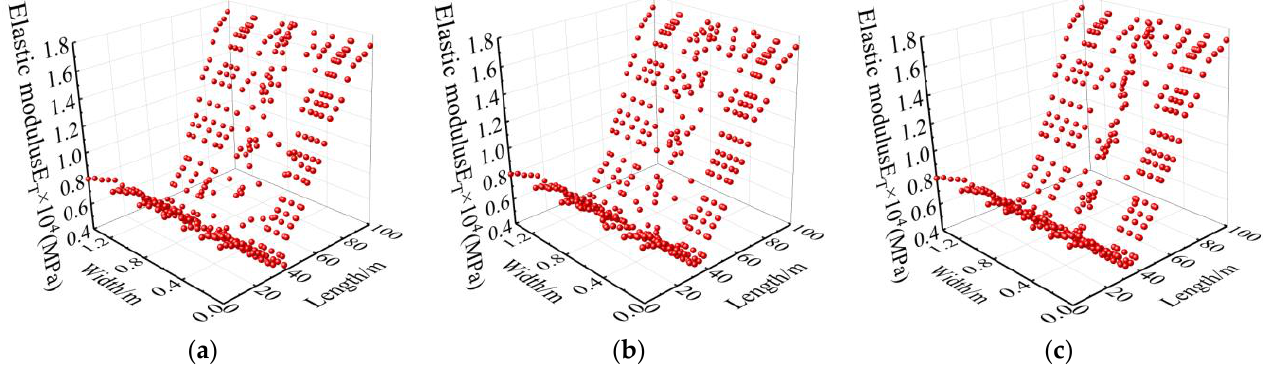
Figure 15. Elastic modulus at different positions in the track bed: ( a ) surface; ( b ) middle; ( c ) bottom.